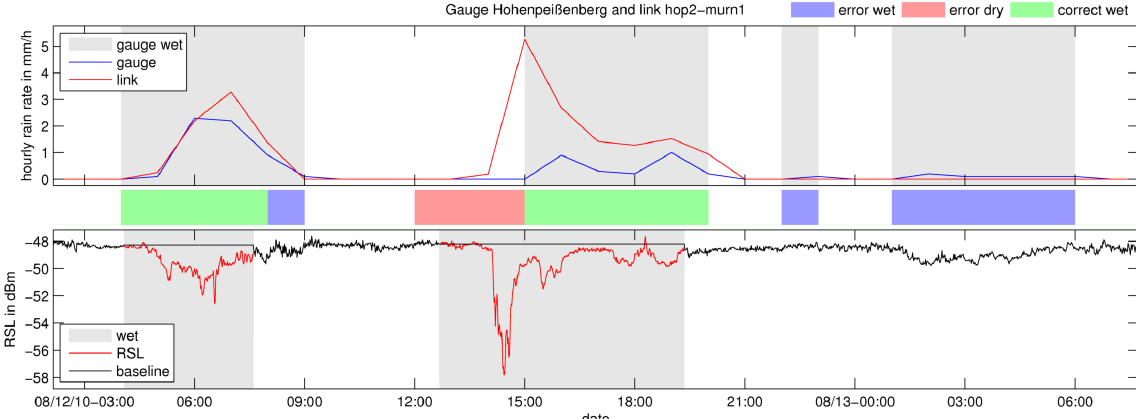
Fig. 7. Same plots as in Fig. 6 but for the link hop2-murn1 and gauge Hoher Peißenberg.